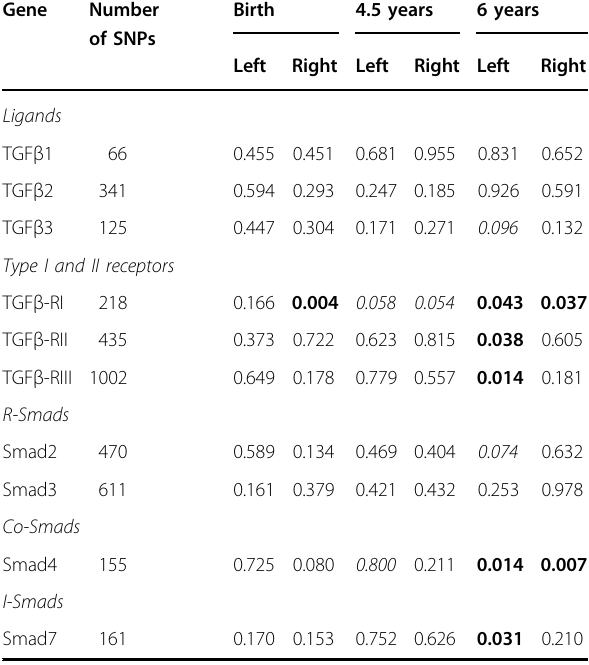
Table 2 Statistical p values for the interactions between the genetic variants and prenatal maternal depressive symptoms on the amygdala volumes at birth and at age of 4.5 and 6